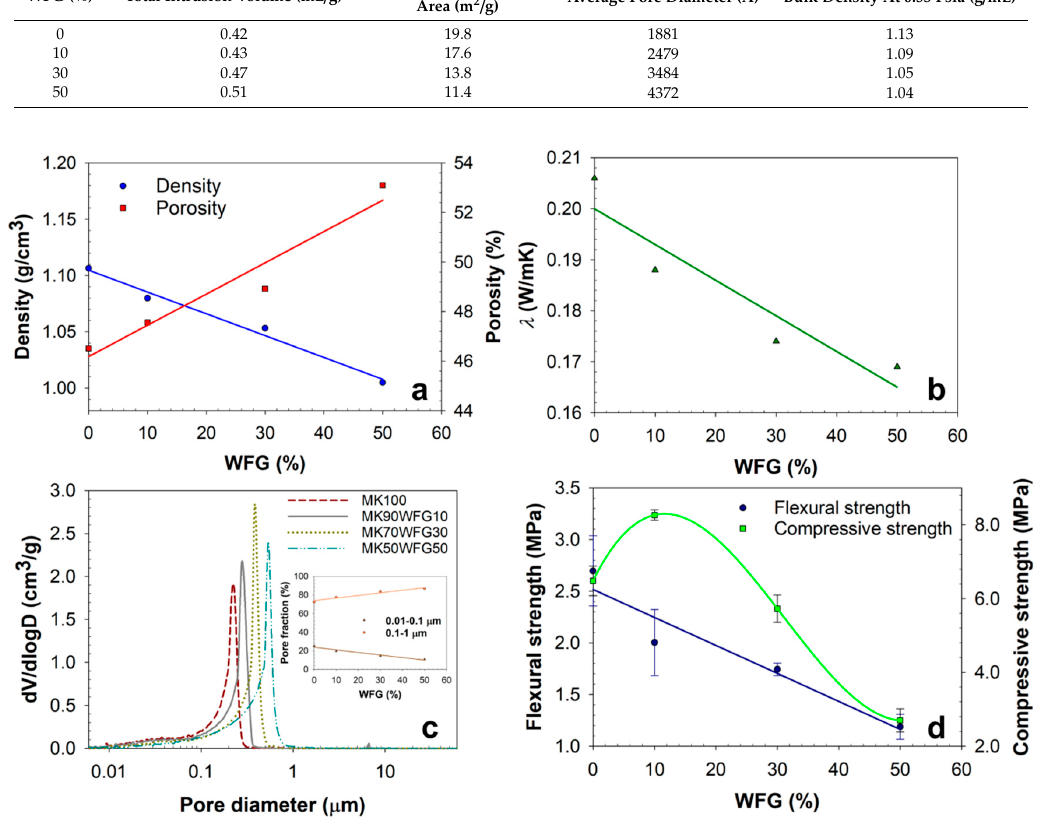
Figure 7. Density and porosity ( a ), thermal conductivity coe ffi cient ( b ), pore–size distribution ( c ) and mechanical strength ( d ) of the produced alkali-activated materials versus the % amount of WFG used.